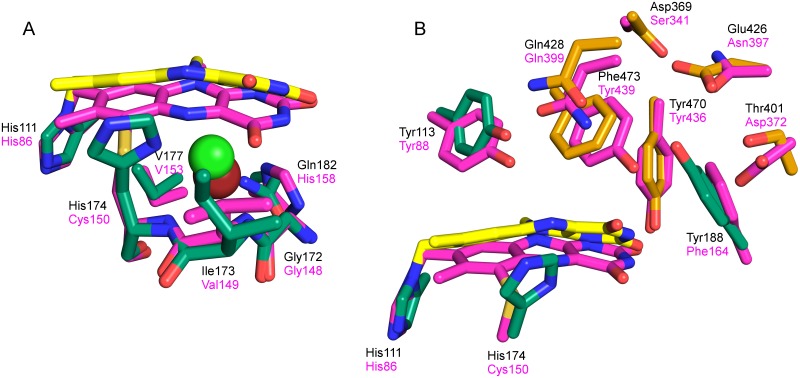
Overlay of AtBBE-like 28 and Phl p 4 I153V N158H.A: re-side: AtBBE-like 28 is shown in green and yellow, Phl p4 (PDB: 4PWC) is shown in magenta. The chloride ion embedded in AtBBE-like 28 is shown in green, bromide from Phl p 4 is shown in red. The oxygen pocket is highly conserved and in both structures occupied by oxygen surrogating halide ions. In Phl p4 the halide ion is complexed by the nitrogen of the peptide bond between Cys150 and Val149 and the nitrogen of the peptide bond between Val149 and Gly148. In AtBBE-like 28 the halide ion is complexed by the corresponding residues, additionally His174 and Gln182 are involved in hydrogen bonds towards the chloride ion. B: si-side: The positions of the active site forming residues are conserved. Their nature has been changed, leading to two different active sites embedded in a very similar protein scaffold. Though the position of the isoalloxazine ring is highly conserved in the BBE-like family the C4 C6 axis of the plane N10 C4 C6 has been shifted 32° resulting in a displacement of N5 by 1.6 Å.